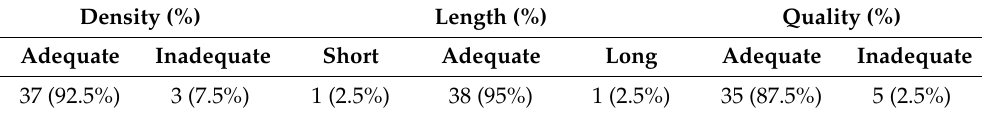
Table 1. Analysis of the obturation length, density, and quality parameters.